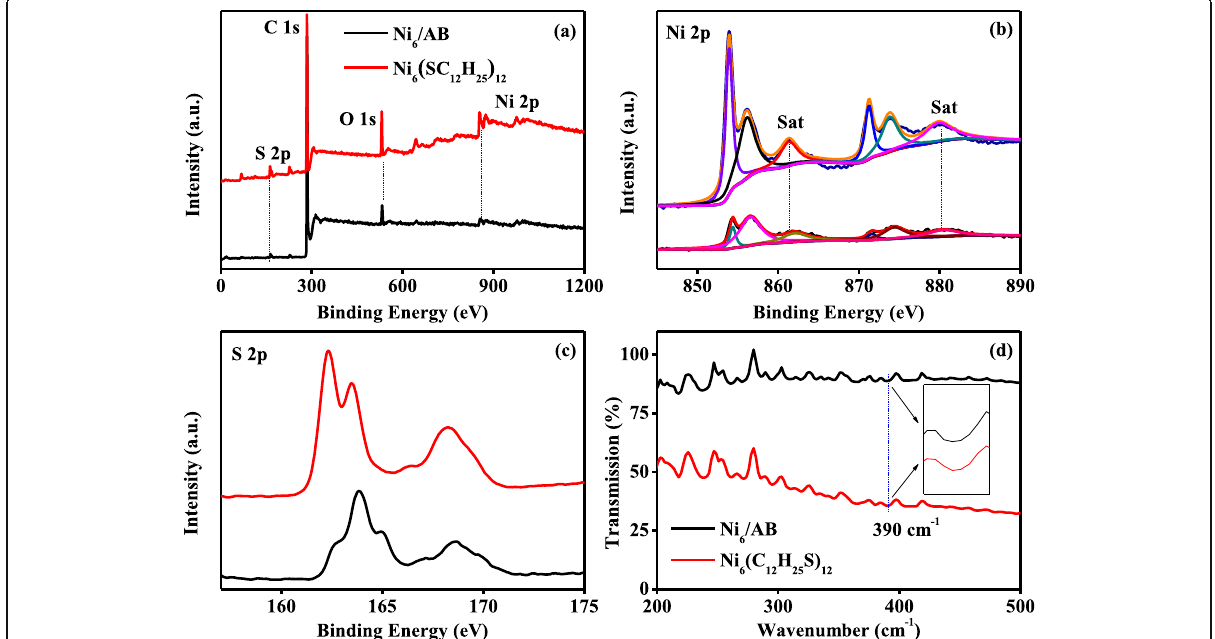
Fig. 2 a XPS survey spectra of Ni 6 /AB composites (red line) and Ni 6 (SC 12 H 25 ) 12 (black line). b The Ni 2p deconvulted XPS spectrum of Ni 6 /AB composites (bottom one) and Ni 6 (SC 12 H 25 ) 12 (upper one). c The S 2p deconvulted XPS spectrum of Ni 6 /AB composites (bottom one, black line), and Ni 6 (SC 12 H 25 ) 12 (upper one, red line). d The FTIR spectra of Ni 6 /AB composites(red line) and Ni 6 (SC 12 H 25 ) 12 (black line). The inset in Fig. 2d is the amplifying region around 390 cm −